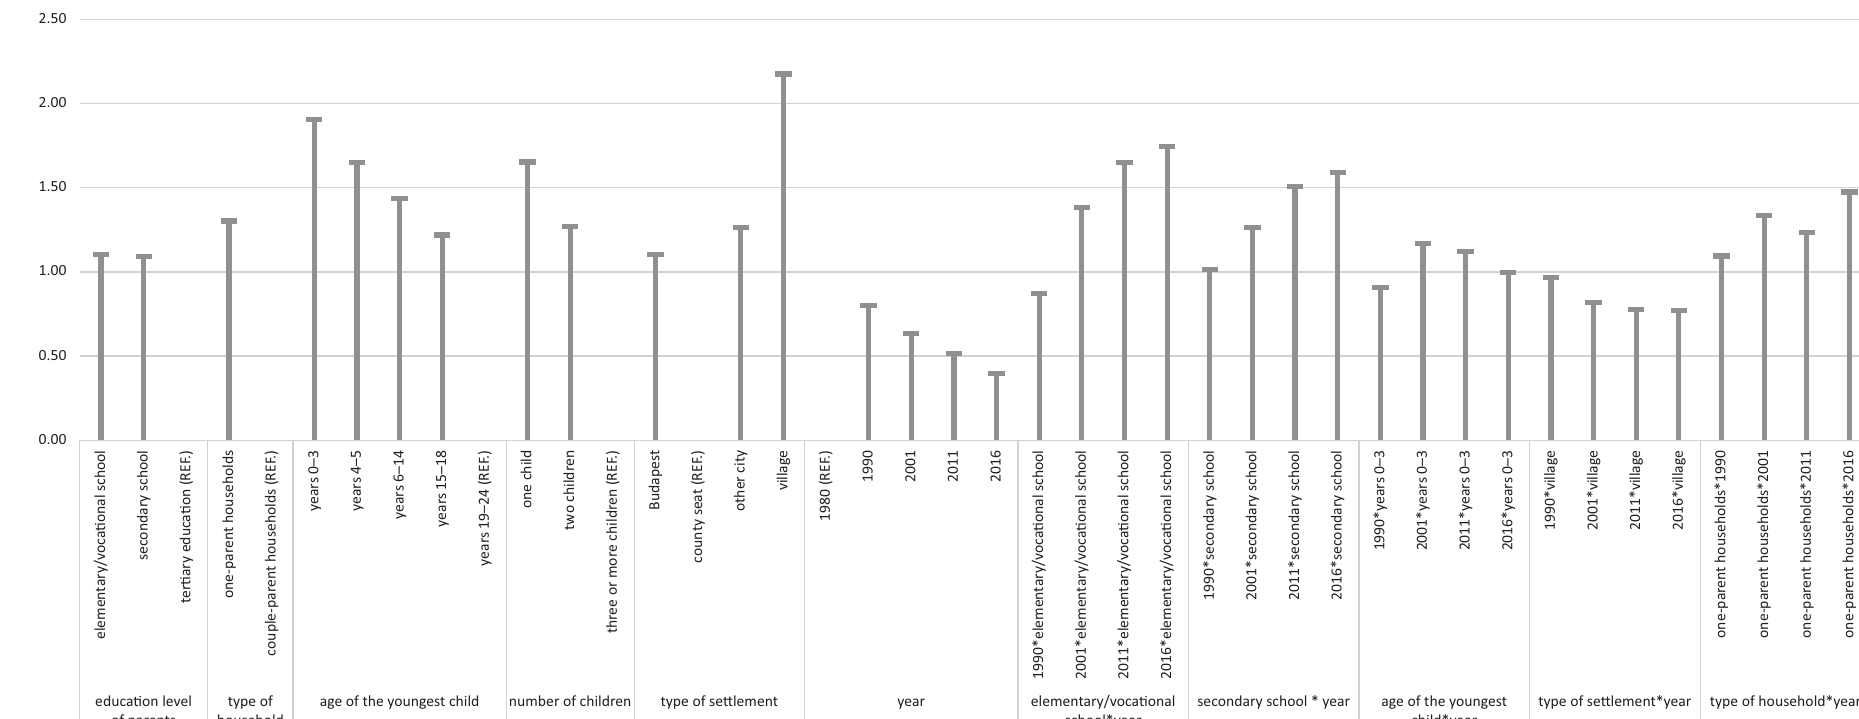
Figure 4. Demographic and sociological characteristics that determine three‐generation living arrangements (results of the logistic regression models, odds ratios). Notes: Household‐ level data; all effects are significant at the p < 0.001 level; dependent variables are non‐TGHs (0) and TGHs (1).